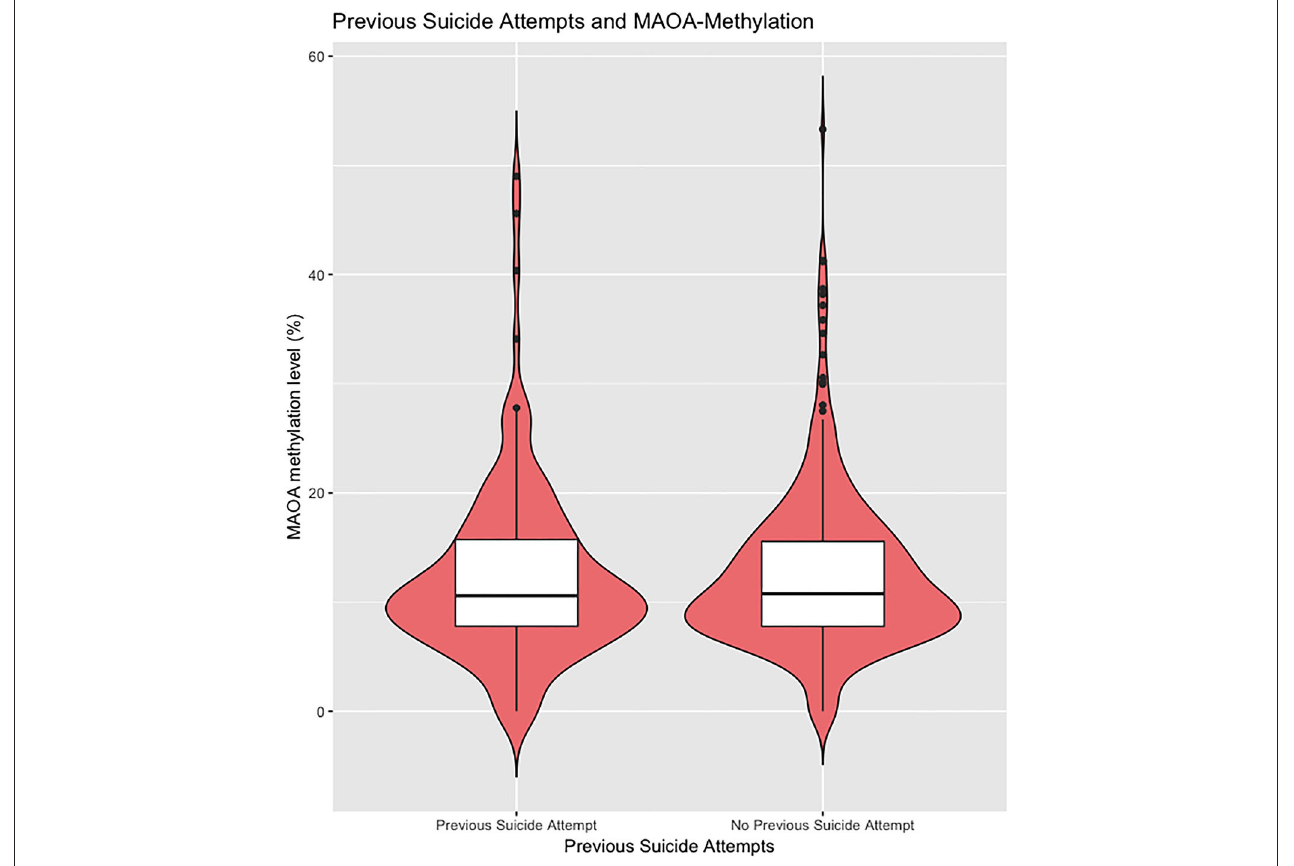
FIGURE 2 | The extent of methylated DNA at MAOA exon I promoter in peripheral blood of female affective disorder patients with and without a personal history of suicide attempt(s) (previous attempt: 14.48 ± 13.83%, n = 138; no previous attempt: 13.50 ± 10.31%, n = 356; p = 0.39, t -test). Violin plot with median and interquartile range.